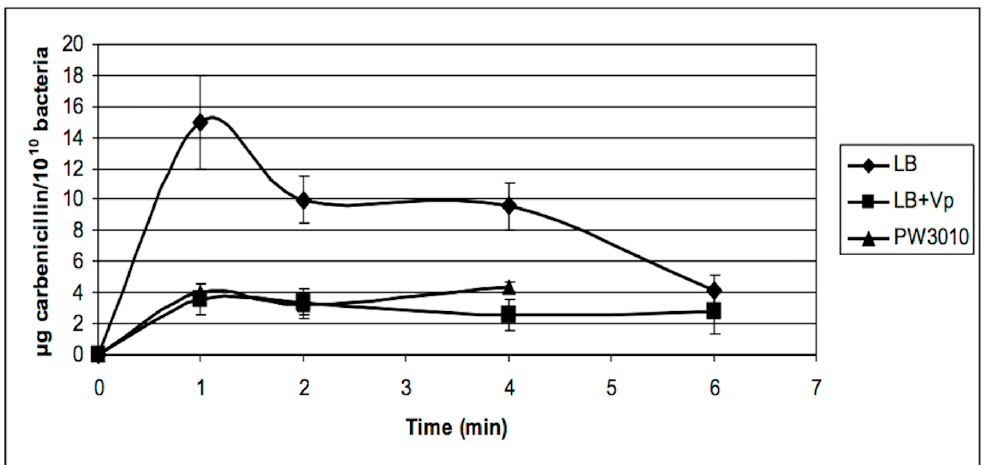
Figure 7. Kinetics of accumulation of carbenicillin in the cytoplasm of P. aeruginosa PAO1 in the presence (LB + Vp) or absence (LB) of verapamil and in the mutant in PA1113 gene (PW3010). P. aeruginosa PAO1 and its mutant PW3010 suspended in LB medium or LB + 1 × 10 − 7 M verapamil at a concentration of 1 × 10 10 bacteria per mL were incubated for 20 min at 37 °C before starting the kinetics. After recovery of the periplasmic contents, PAO1 protoplasts were lysed by sonication and